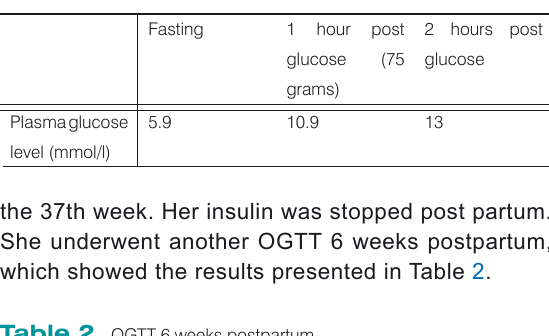
Table 2. OGTT 6 weeks postpartum. Fasting